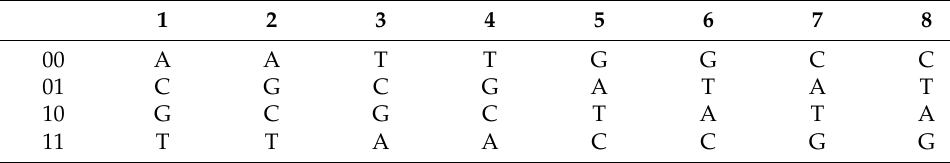
Table 1. The rules of DNA encoding and decoding.